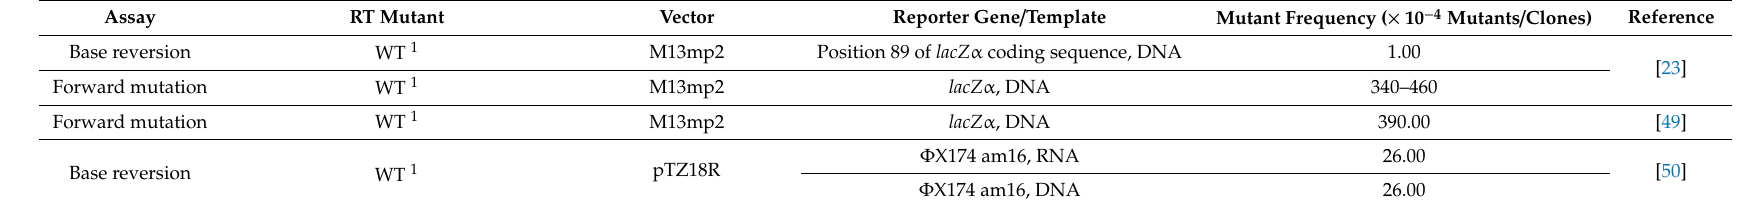
Table 2. Mutant frequencies of HIV-1 RT measured in cell-free fidelity